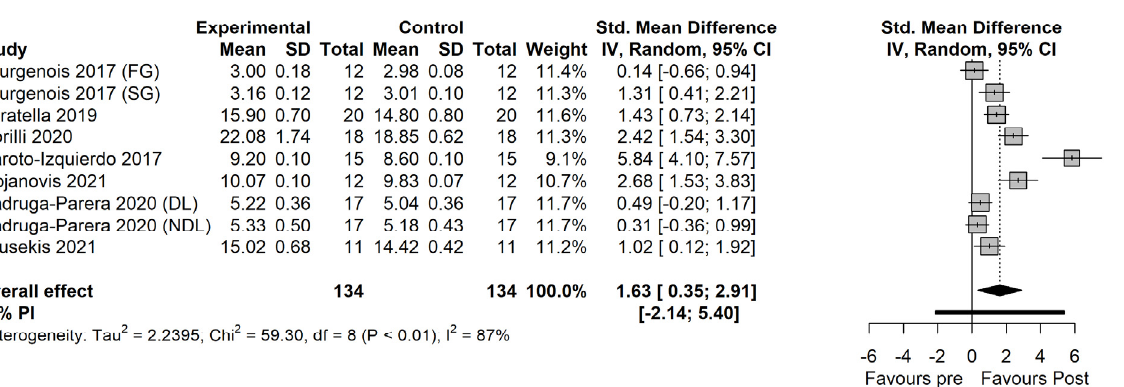
Figure 4. The effects of flywheel resistance training on change of direction performance in male athletes [22–28]. FG: fast group; SG: slow group; DL: dominant leg; NDL: non-dominant leg; RL: right leg.